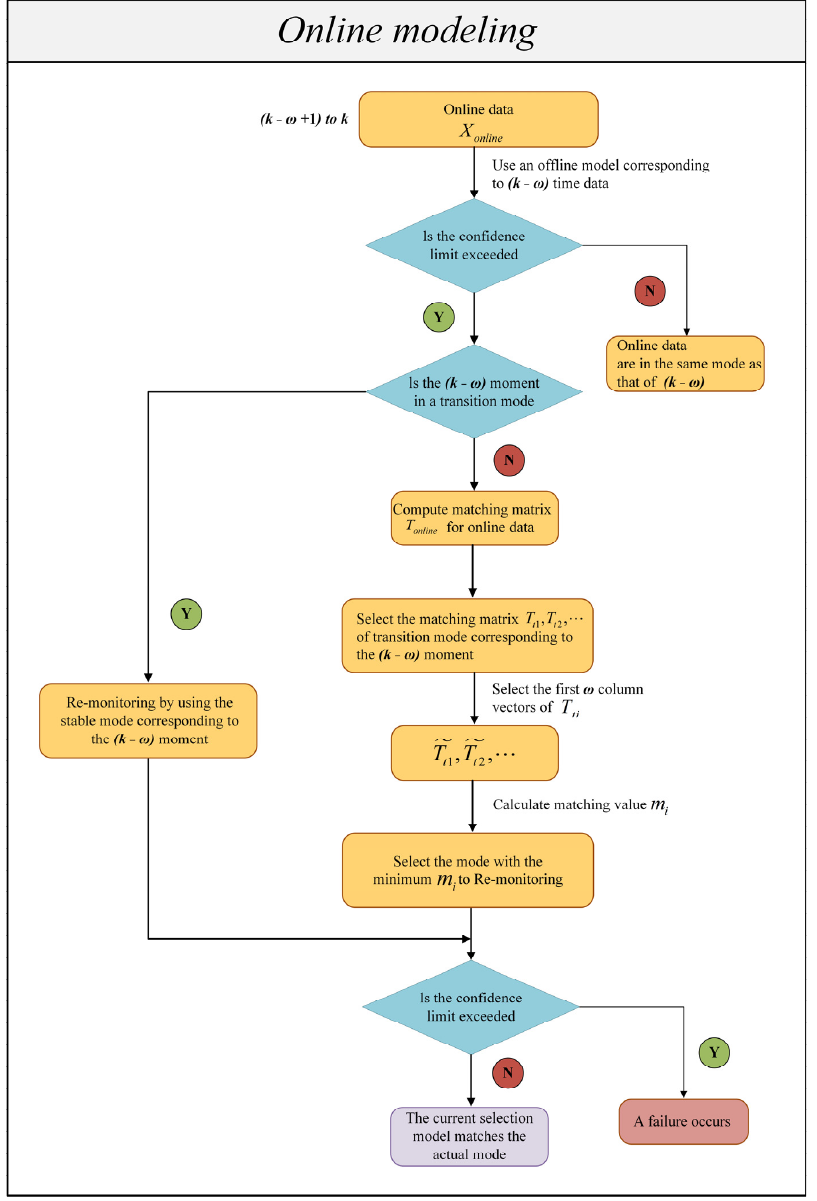
Figure 3. Flowchart of the online modeling.